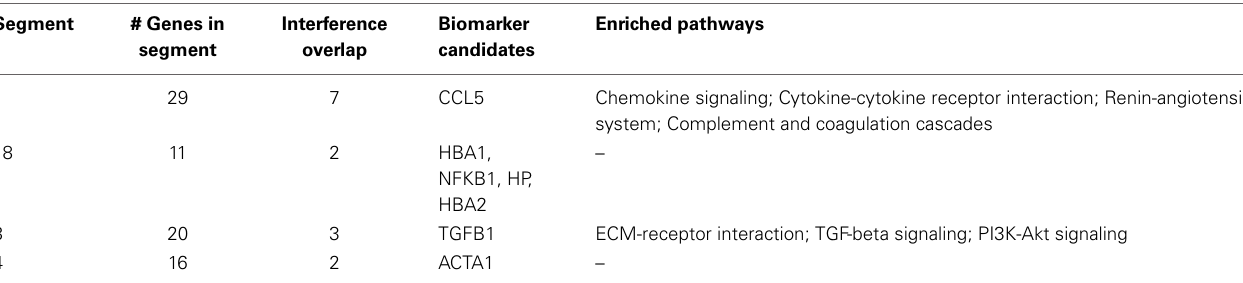
Table 4 | Diabetic nephropathy process segment